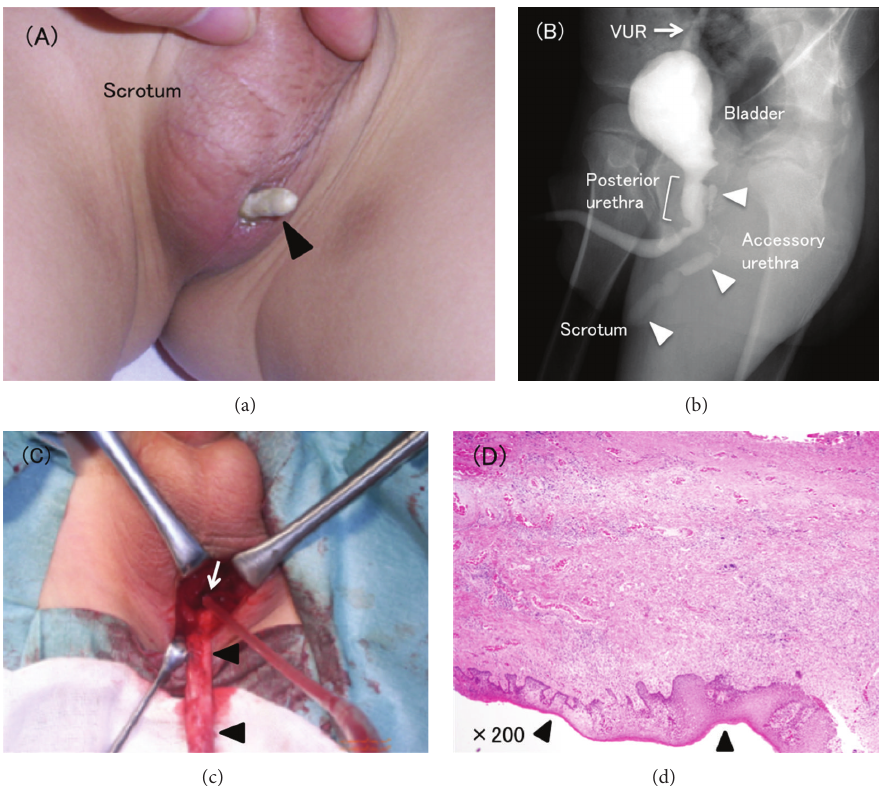
Figure 1: (a) The opening of the sinus with urinary stone (arrowhead) in the midline scrotum. (b) VCUG demonstrated the accessory urethra arising from the posterior urethra to the scrotum (arrowheads) and right grade I VUR (arrow). (c) The 4.5 cm long accessory urethra (arrowheads) was removed through a scrotal incision. White arrow was the junction of posterior urethra and accessory urethra. (d) The sinus lumen was lined by squamous epithelium with keratinization (arrowheads). Capillary vessels and smooth muscle tissue were observed in subepithelium (HE, ×